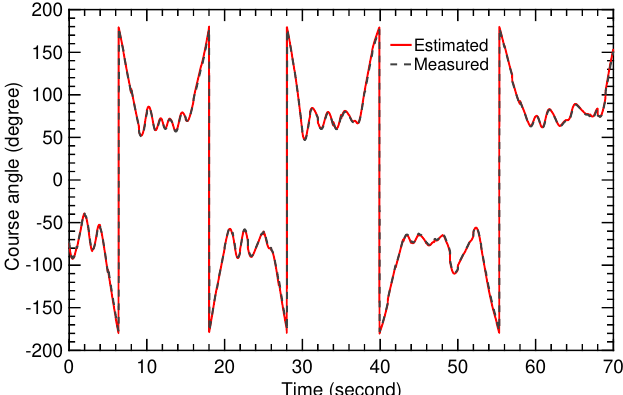
Figure 24. Time history of measured and estimated course